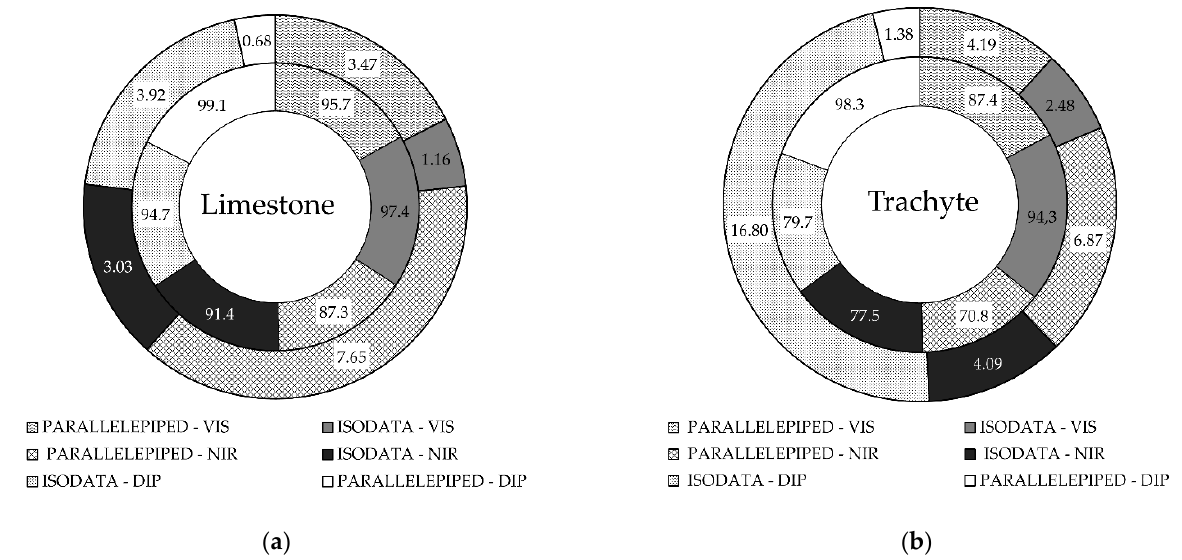
Figure 10. Pie charts of overall accuracies and standard deviations computed for each imaging technique using: ( a ) limestone; and ( b ) trachyte aggregates.